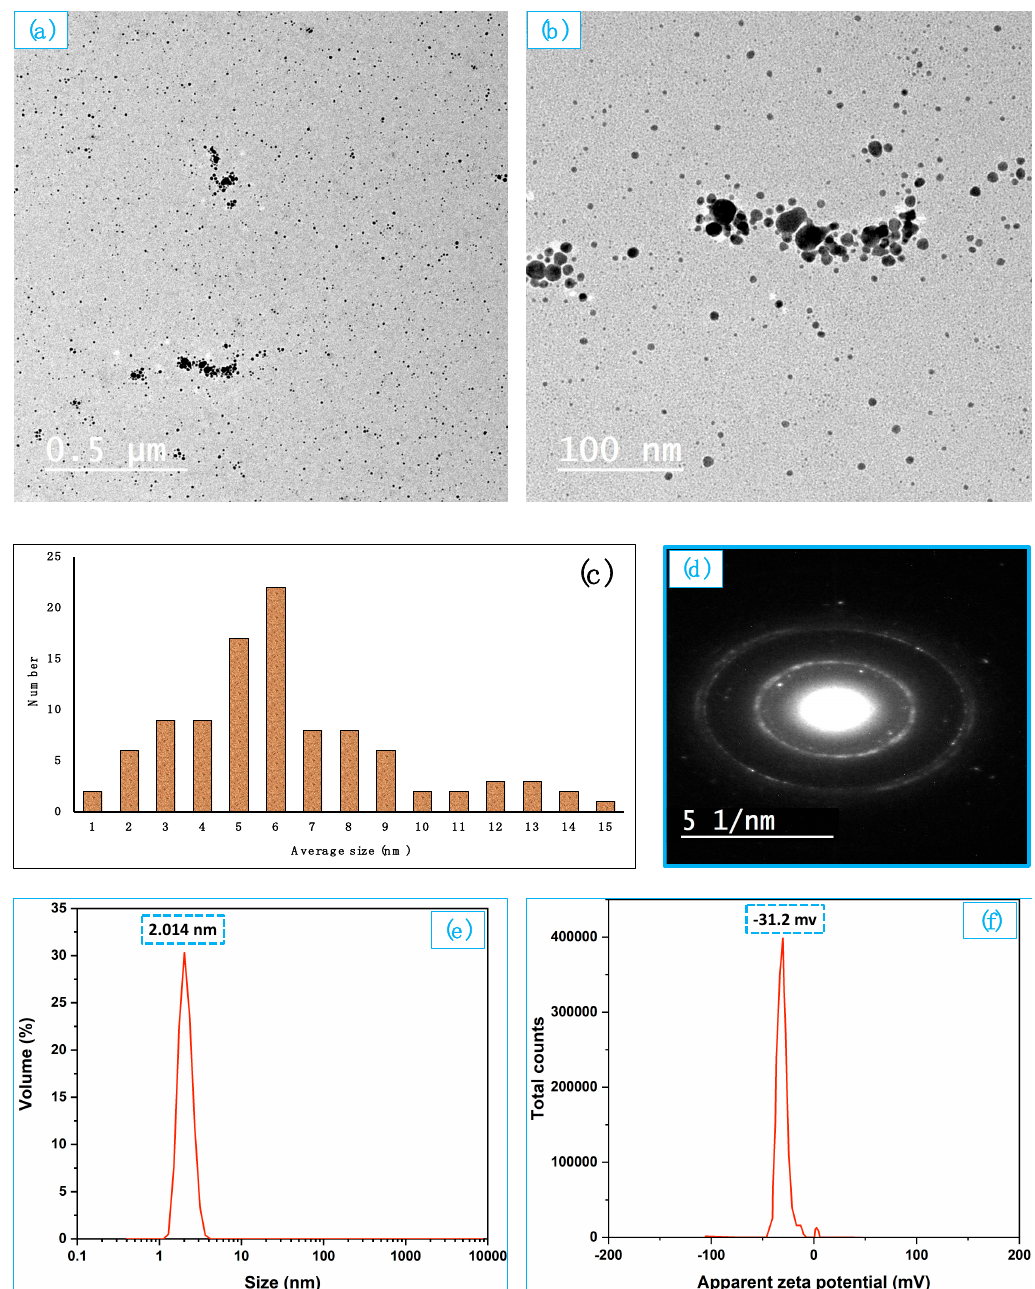
Figure 2. ( a , b ) TEM im©s, ( c ) distribution size calculated from TEM©ages ( d ) SAED, ( e ) hydrody- namic particle size and ( f ) zeta potential of AgNPs.